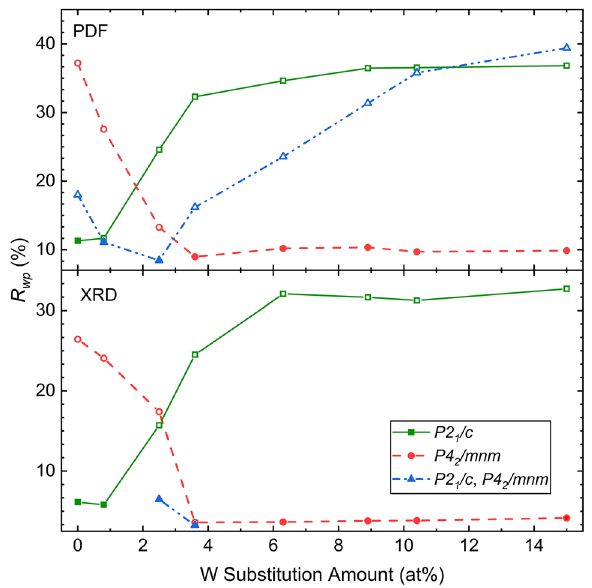
Figure 3. Comparison of the goodness-of-fit parameter, R wp , from both XRD (> 30 Å) and PDF data (1.5–30 Å) illustrates how the local structure begins to transition from the monoclinic to the tetragonal structure before the average structure based on tungsten substitution amount. This exemplifies the need for greater local structure studies for predicting and explaining the properties if substituted VO 2 is to be engineered and implemented in a functional capacity.